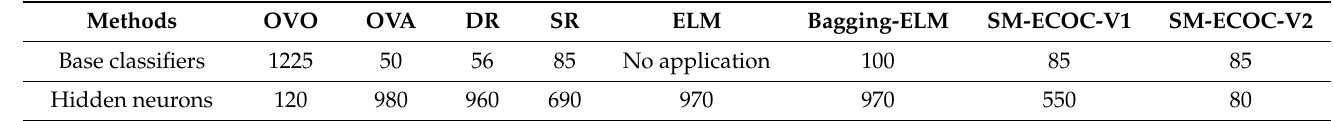
Table 5. The number of base classifiers and hidden neurons for different